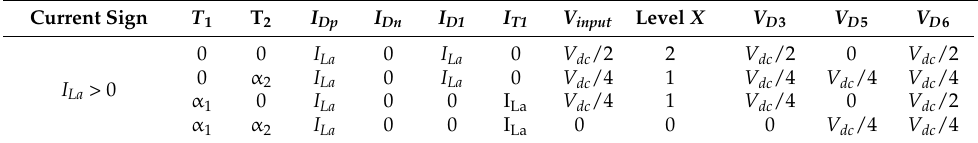
Table 2. The switches’ states and the average values of the current and voltage for I La > 0. Current Sign T 1 T 2